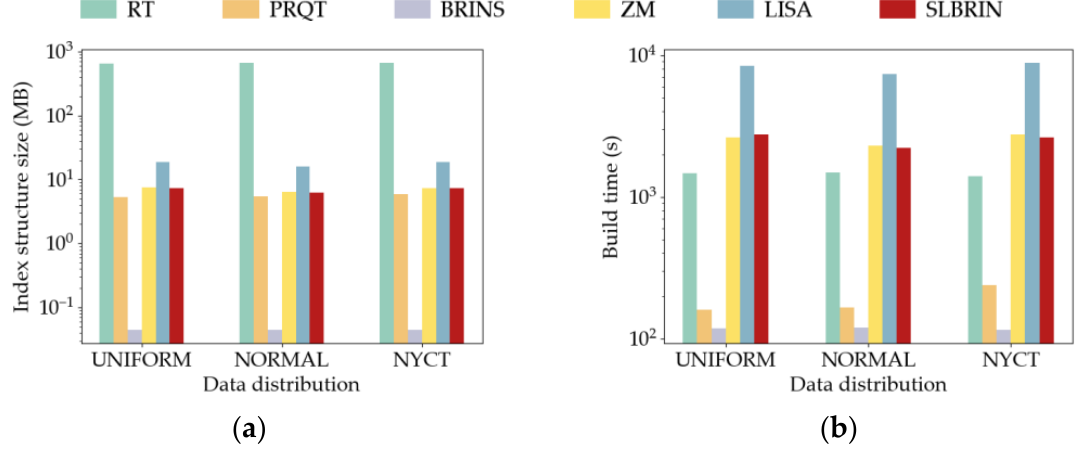
Figure 5. Build performance vs. data distribution. ( a ) Index structure size. ( b ) Build time.